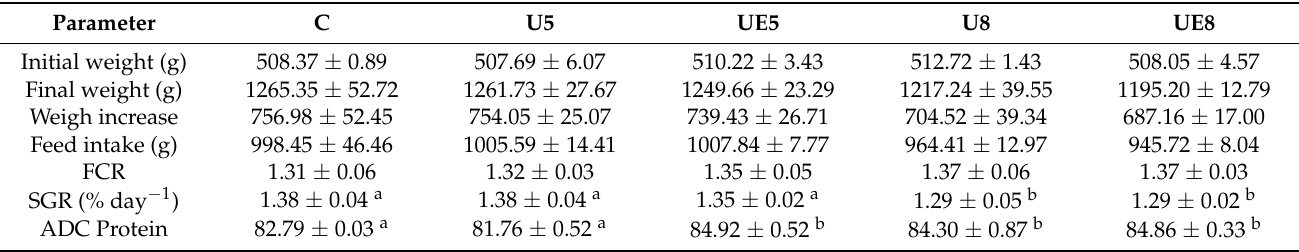
Table 4. Experiment 2. Growth and efficiency in the use of food in experimental feeds. Values are presented as mean ± SD. Values in a row not sharing the same letter are significantly different, with p < 0.05. FCR: feed conversion ratio; SGR: specific growth rate; ADC: apparent digestibility coefficient.